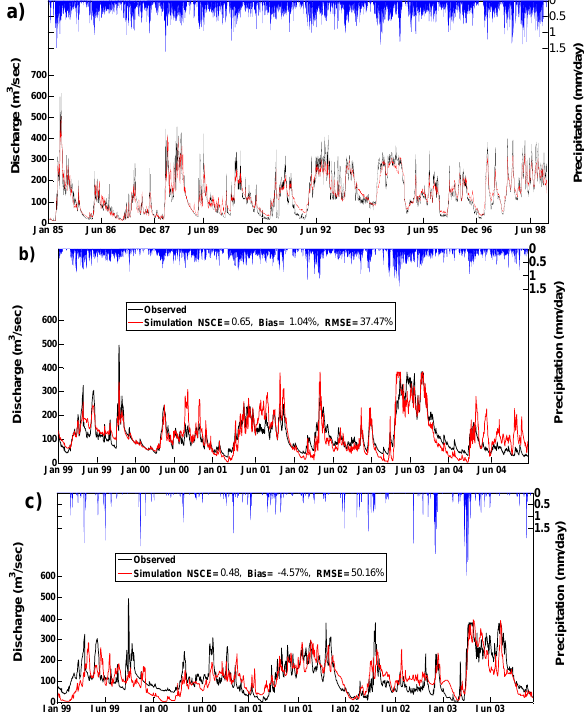
Fig. 5. Daily precipitation, observed and simulated runoff for a) calibration period (1985-1998), b) validation period (1999-2004), c) validation with the TRMM 3B42 V6 from (1999-2003).